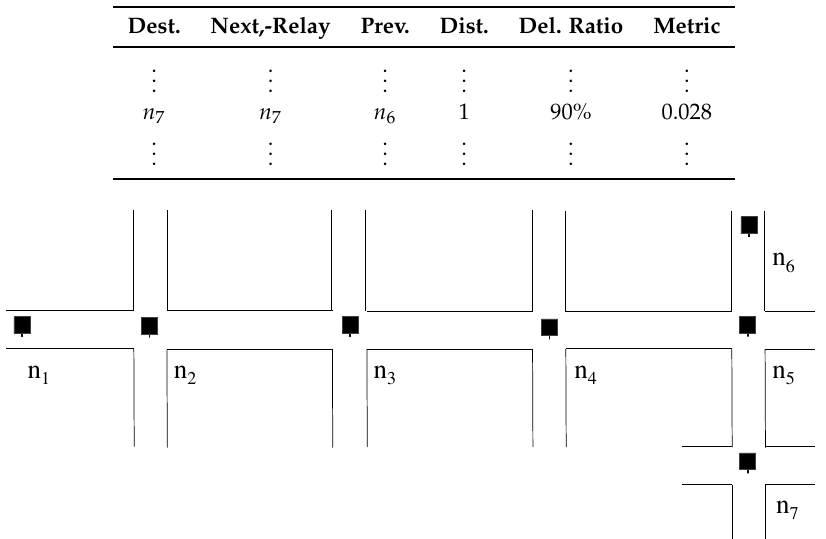
Table 3. Routing Table of n 5 in Figure 3.